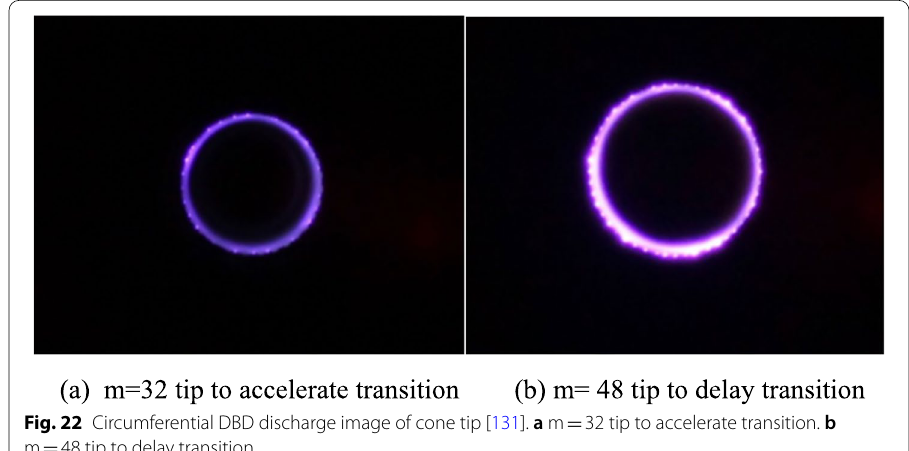
Fig. 22 Circumferential DBD discharge image of cone tip [131]. a m m 48 tip to delay =